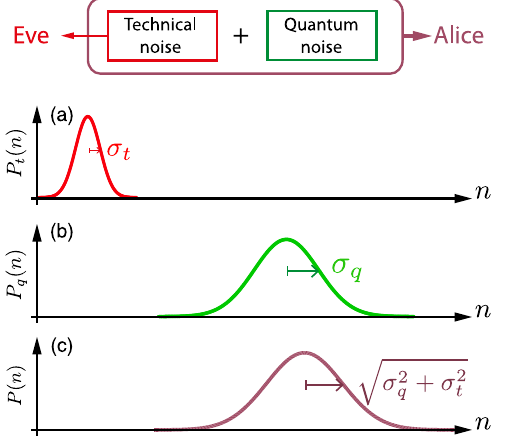
FIG. 2. Working principle and assumptions. (a) We measure a number n of photoelectrons on an image sensor ’ s pixel with a probability P ð n Þ . Assuming that the detector is operating in a linear regime, this measured distribution will be the combination of quantum uncertainty (b) and technical noise (c). From a single shot measurement, we cannot distinguish these two noise components; however, we assume that, to our adversary, the technical noise is fully